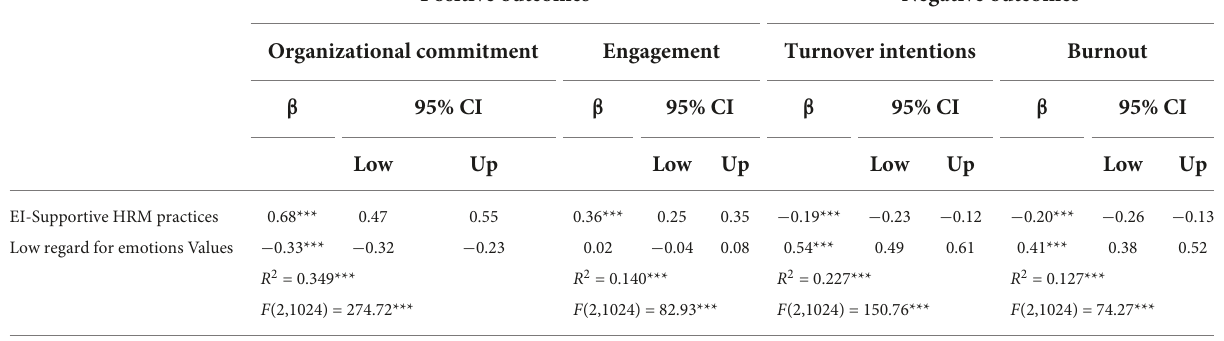
TABLE 2 Study 1–Regression analysis for the relationship between EI-supportive HRM practices, low regard for emotions values and the outcome variables (standardized coefficients). Positive outcomes Negative outcomes Organizational commitment